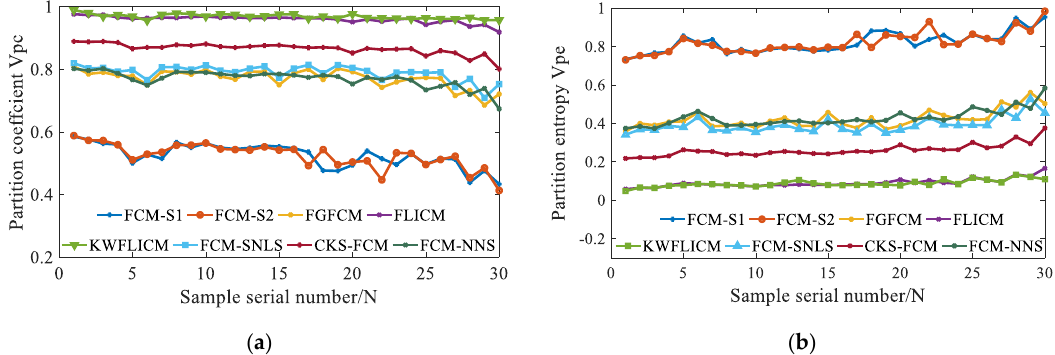
Figure 14. The v pc and v pe values of the proposed and the compared algorithms on thirty aliasing images. ( a ) The v pc values of the proposed and the compared algorithms on thirty aliasing images, ( b ) The v pe values of the proposed and the compared algorithms on thirty aliasing images.